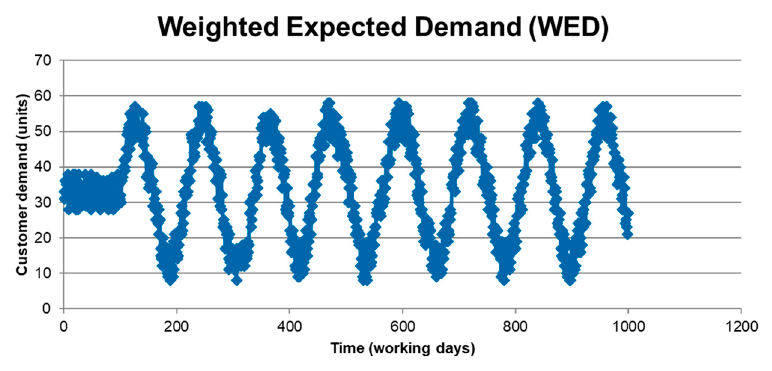
Figure 9. Weighted expected demand (WED) (own elaboration).